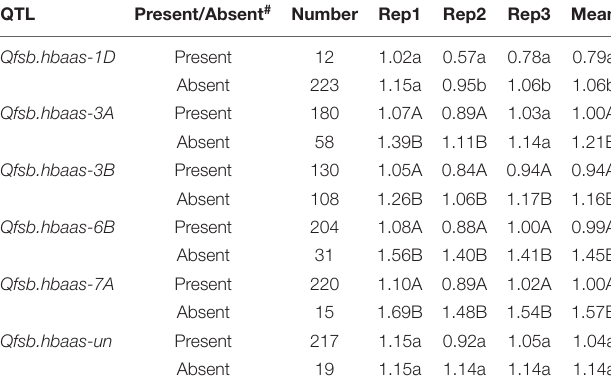
TABLE 5 | Primer sequences of single nucleotide polymorphism (SNP) markers for validation in wheat lines by Kompetitive Allele-Specific PCR (KASP) assay. QTL